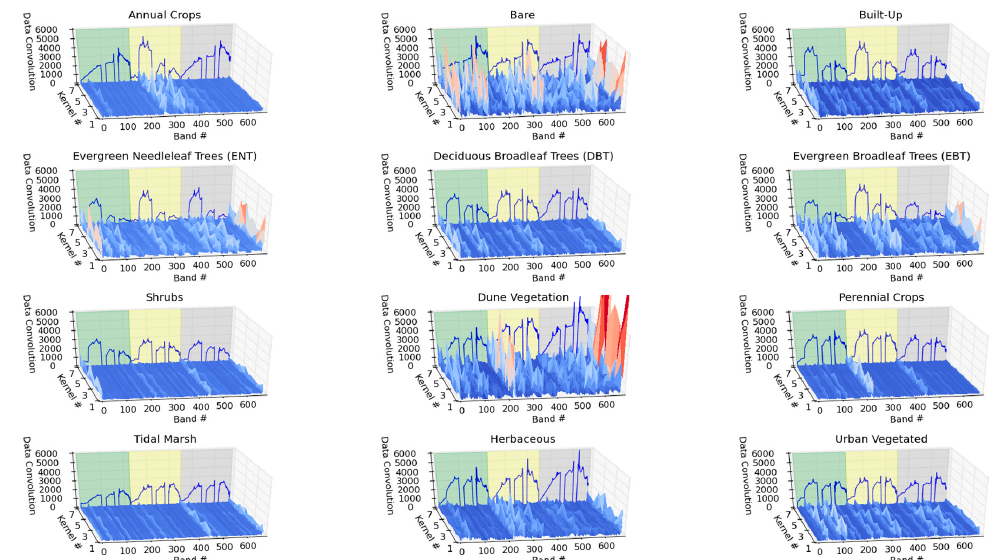
Figure 10. Convolutional feature maps for each class for the three-season CNN. These feature maps are the result of averaging the convolution of the kernels with 75 spectra per class (Section 2.4.3). An example class spectrum is shown in background. Green, yellow and gray background areas represent bands in the spring, summer and fall, respectively. Each season has 186 bands, ordered 370 to 2500 nm. However, in this figure the original 224 bands per season are shown in order to display the bad data gaps (e.g., atmospheric absorption windows).